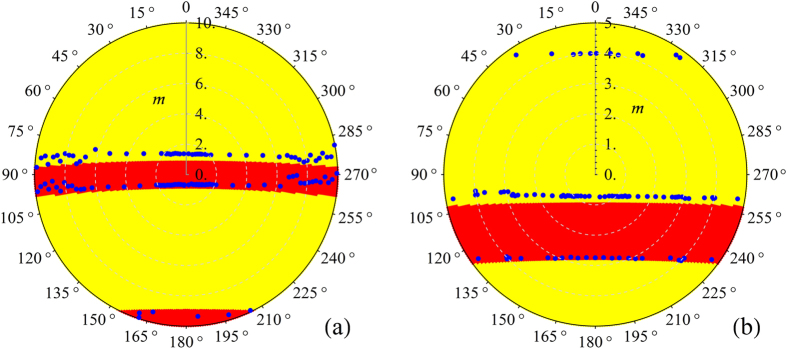
Polar map representation.(a) corresponds to Fig. 1(b) and (b) to Fig. 1(c) respectively.